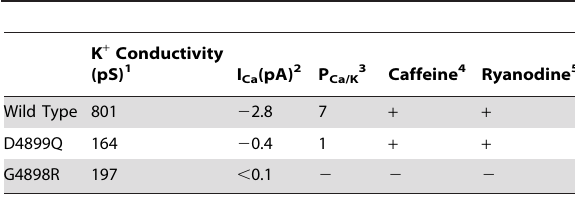
Table 2. Experimental characteristics of RyR1-WT,